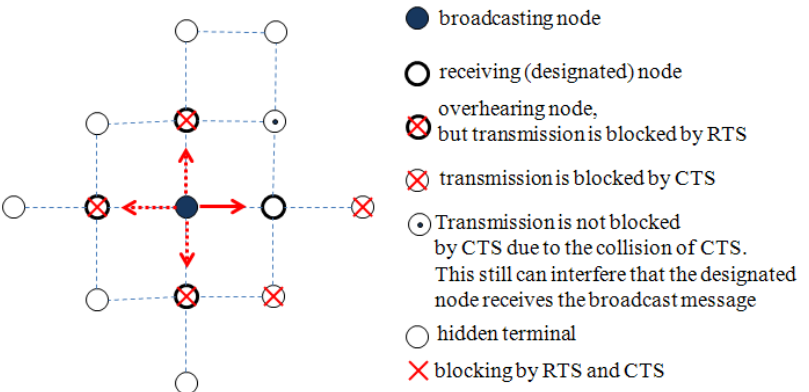
Figure 1. The illustration of the hidden terminal